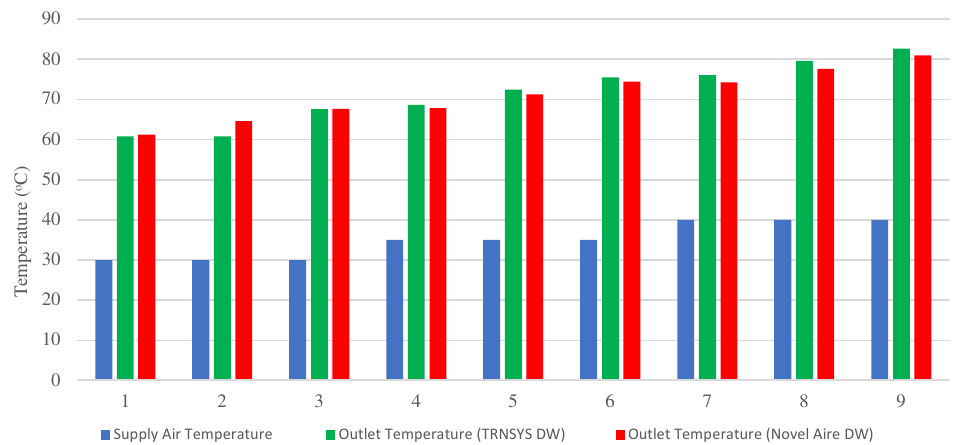
Figure 7. Comparison of the process air outlet temperatures of the DDW from TRNSYS and Novel Aire simulation software from Table 1. The differences in the humidity ratio between the TRNSYS models and Novel Aire simulation software were also not significant; the data show that the difference in the hu- midity ratio is minimal on the process air side of the DDW, with the differences between the TRNSYS models and the Novel Aire simulation software varying between 0.5 and 1.7 g/kg (Figure 8). The differences in the process air outlet temperature and humidity ratio of the TRNSYS DDW component and the Novel Aire simulation software can possibly be attributed to the differences in the materials used in the desiccant wheel that each of the software is based on, as manufacturers of desiccant wheels will each have their own unique formulations in the material compositions of their desiccant wheels.